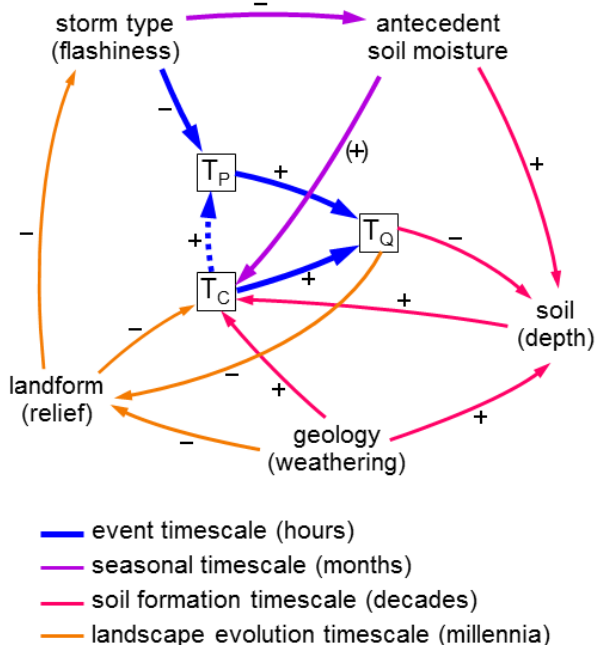
Figure 3. Schematic of the coupling of process controls on the flood timescale. Plus and minus signs indicate whether coupling is pos- itive or negative, i.e. whether an increase in a variable increases or decreases another variable. T P : precipitation timescale, charac- teristic duration of rainfall producing a maximum annual flood; T C : catchment response timescale, time delay of catchment rout- ing; T Q : flood timescale, characteristic flood duration (from Gaál et al.,